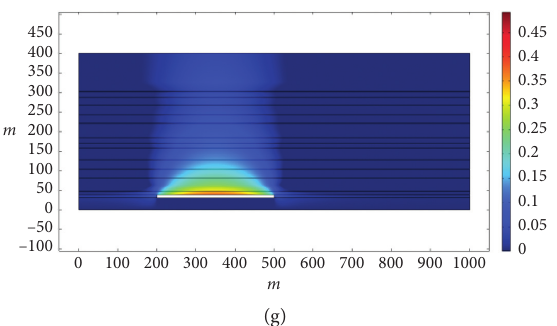
Figure 4: Stress nephogram and displacement nephogram at different working face lengths. (a) Numerical simulation geometry model. (b) Stress nephogram when working face length is 120m. (c) Displacement nephogram when working face length is 120m. (d) Stress nephogram when working face length is 160m. (e) Displacement nephogram when working face length is 160 m. (f) Stress nephogram when working face length is 200m.(g) Displacement nephogram when working face length is